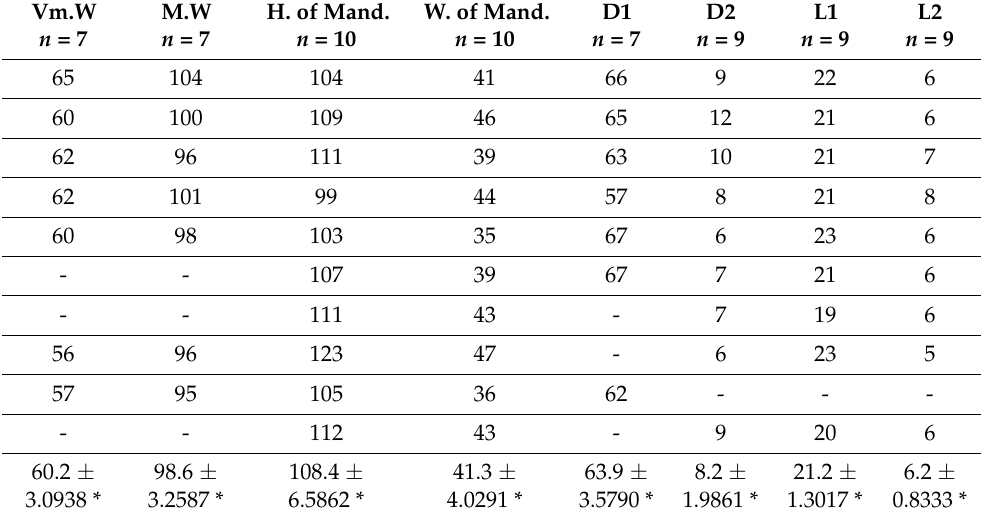
Table 2. Morphology of 10 Belgica antarctica fourth-instar larvae collected from the un-named island near Enterprise Island. Measurements (in µ m) are presented of: Vm.W—width of ventro- mentum, including the middle tooth + two teeth on both sides; M.W.—width of mentum; H. of mand.—height of the mandible; W. of mand.—width of mandible; D1—distance between setae of mentum; D2—distance from base to the RO of the first antennal segment; L1 and L2—length of antennal segments 1 and